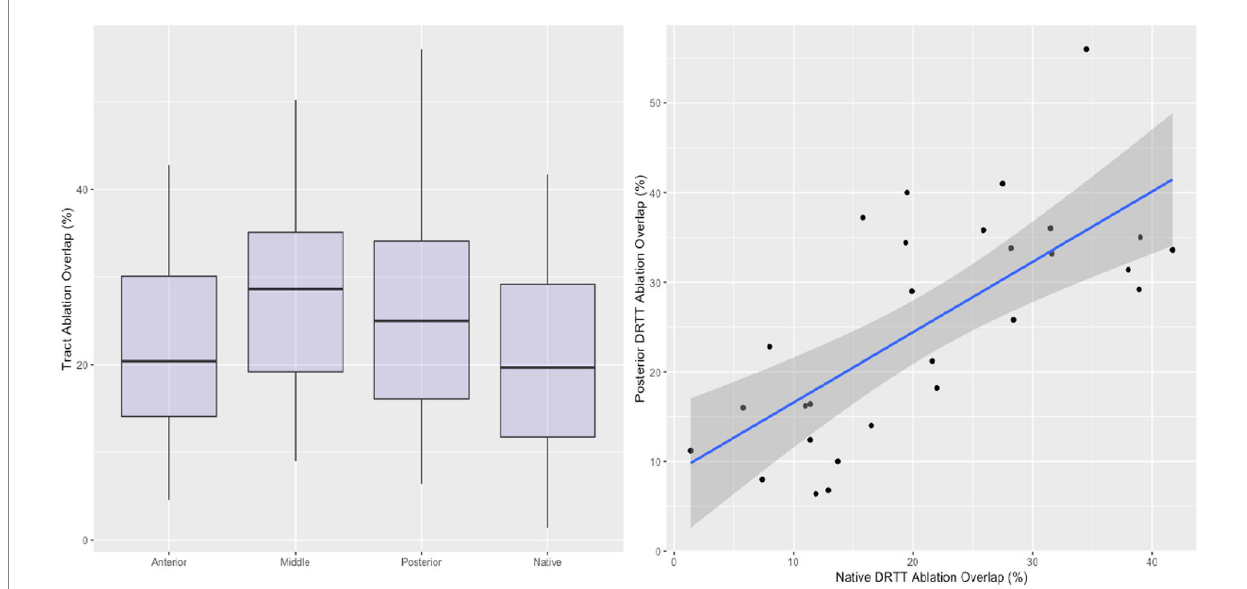
FIGURE 3 Boxplots displaying the ablation overlap for the native DRTT and 3 template DRTT clusters (left). Correlation between the ablation overlap between the native DRTT and the posterior template DRTT (right). Line of best fit indicated by blue line, and 95% confidence interval indicated by shaded region.